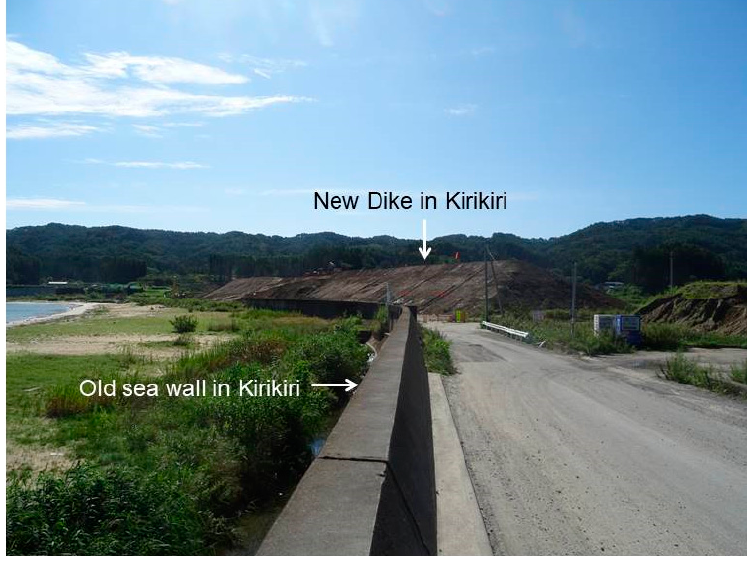
Figure 8. The new dyke in Kirikiri was rebuilt to a higher level.